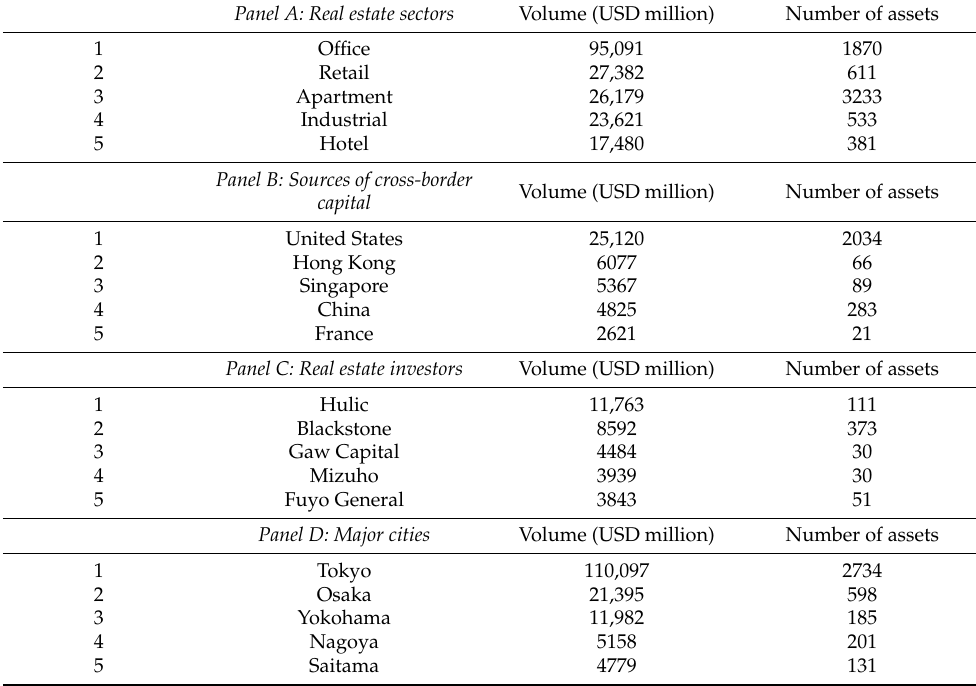
Table 2. Japan commercial real estate transactions: